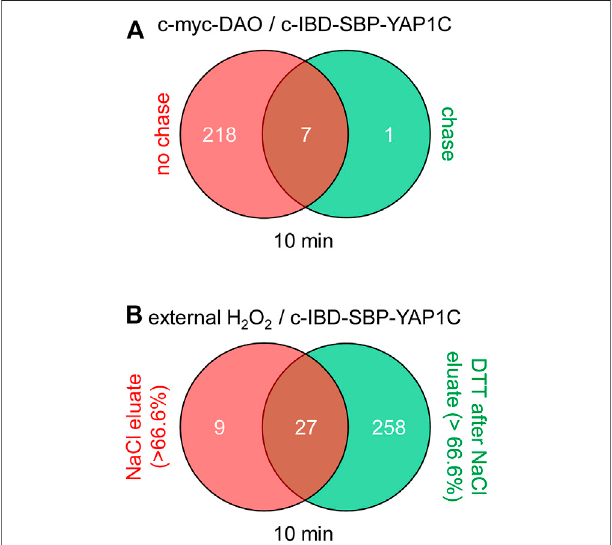
FIGURE 10 | Venn diagrams showing the number and overlap of c-IBD- SBP-YAP1C interactors under different experimental conditions. (A) c-DD- DAO-driven H 2 O 2 production in the absence or presence of a 24-h chase period. (B) External H 2 O 2 addition and elution of the interactors fi rst with 1 M NaCl and subsequently with 10 mM DTT. The threshold values to belong to a speci fi cgroup re fl ect the percentage ofprotein recovered in each fraction relativetothetotalprotein abundance (red: > 66.6% intheNaCl eluate; green: > 66.6%intheDTTafter NaCleluate;brown: lessthan66.6%inbotheluates).